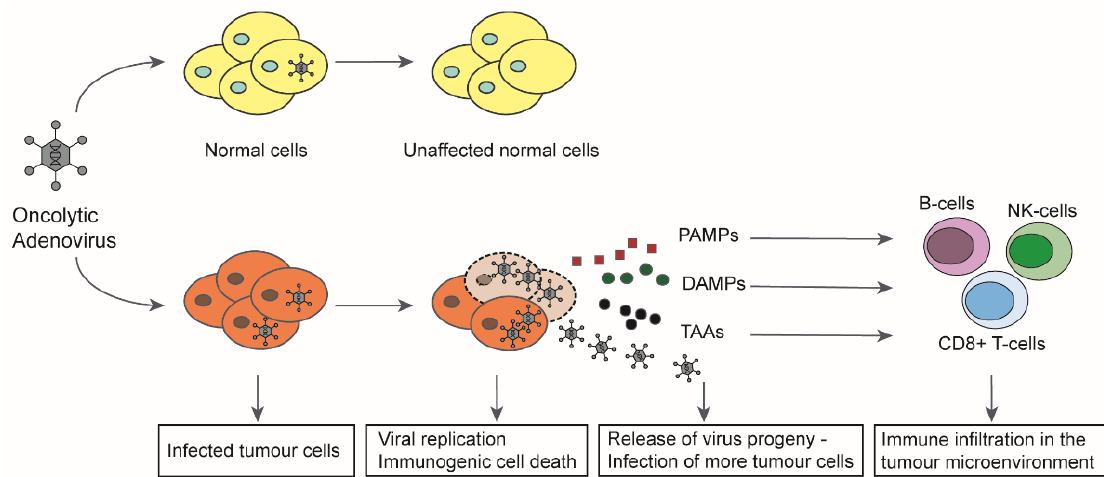
Figure 2. Mechanism of action of oncolytic adenoviruses in cancer cells. In normal, non-cancerous cells, oncolytic adenoviruses are unable to replicate upon infection leaving the cells unaffected. In tumour cells, the viruses can successfully replicate upon infection, leading to production of more virus progeny and eventual induction of immunogenic cell death (ICD). The cell lysis leads to release of virus progeny, pathogen-associated molecular patterns (PAMP), damage-associated molecular patterns (DAMP), and tumour associated antigens (TAA) into the tumour microenvironment (TME). The released virus progeny further infects the uninfected tumour cells and continues the viral spread. The immunostimulatory molecules released into the TME attract immune cells to the tumour and lead to the activation of both innate and adaptive immunity against the tumour (modified with permission from [52,54] ).